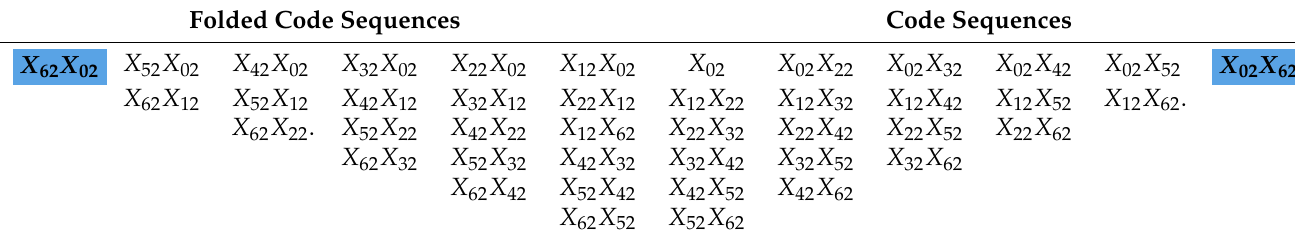
Table 2. Code sequences tree for P =